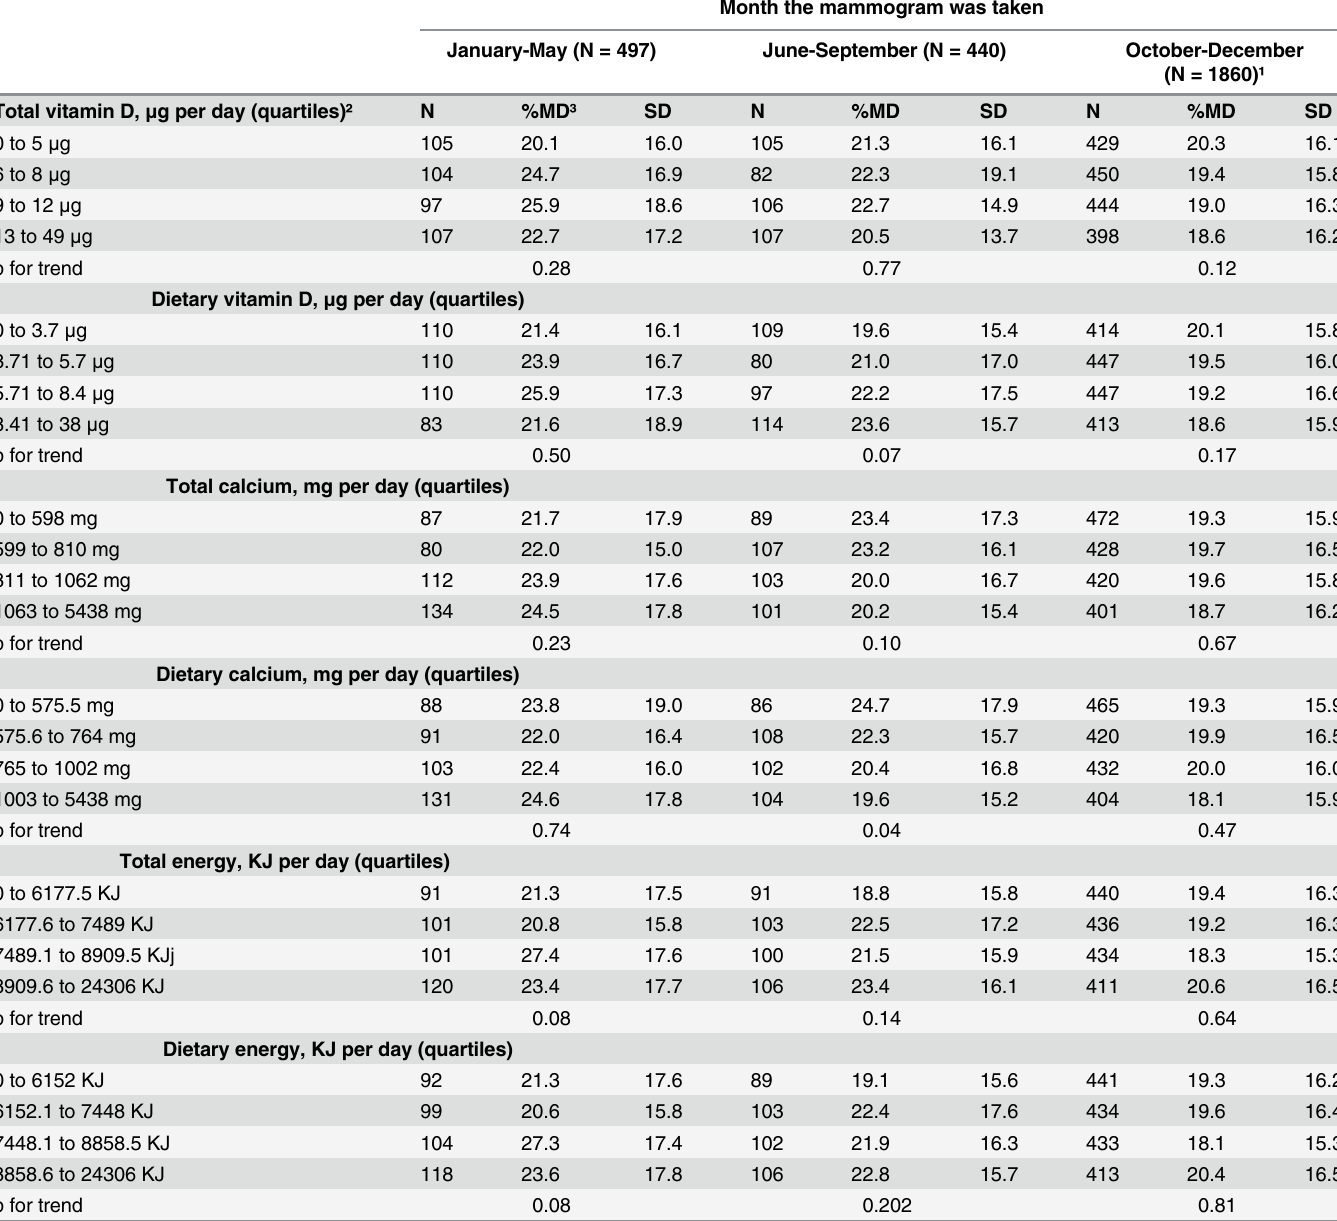
Table 3. Percent mammographic density (%MD) by quartiles of vitamin D, calcium and energy intakes, stratified by month the mammogram was